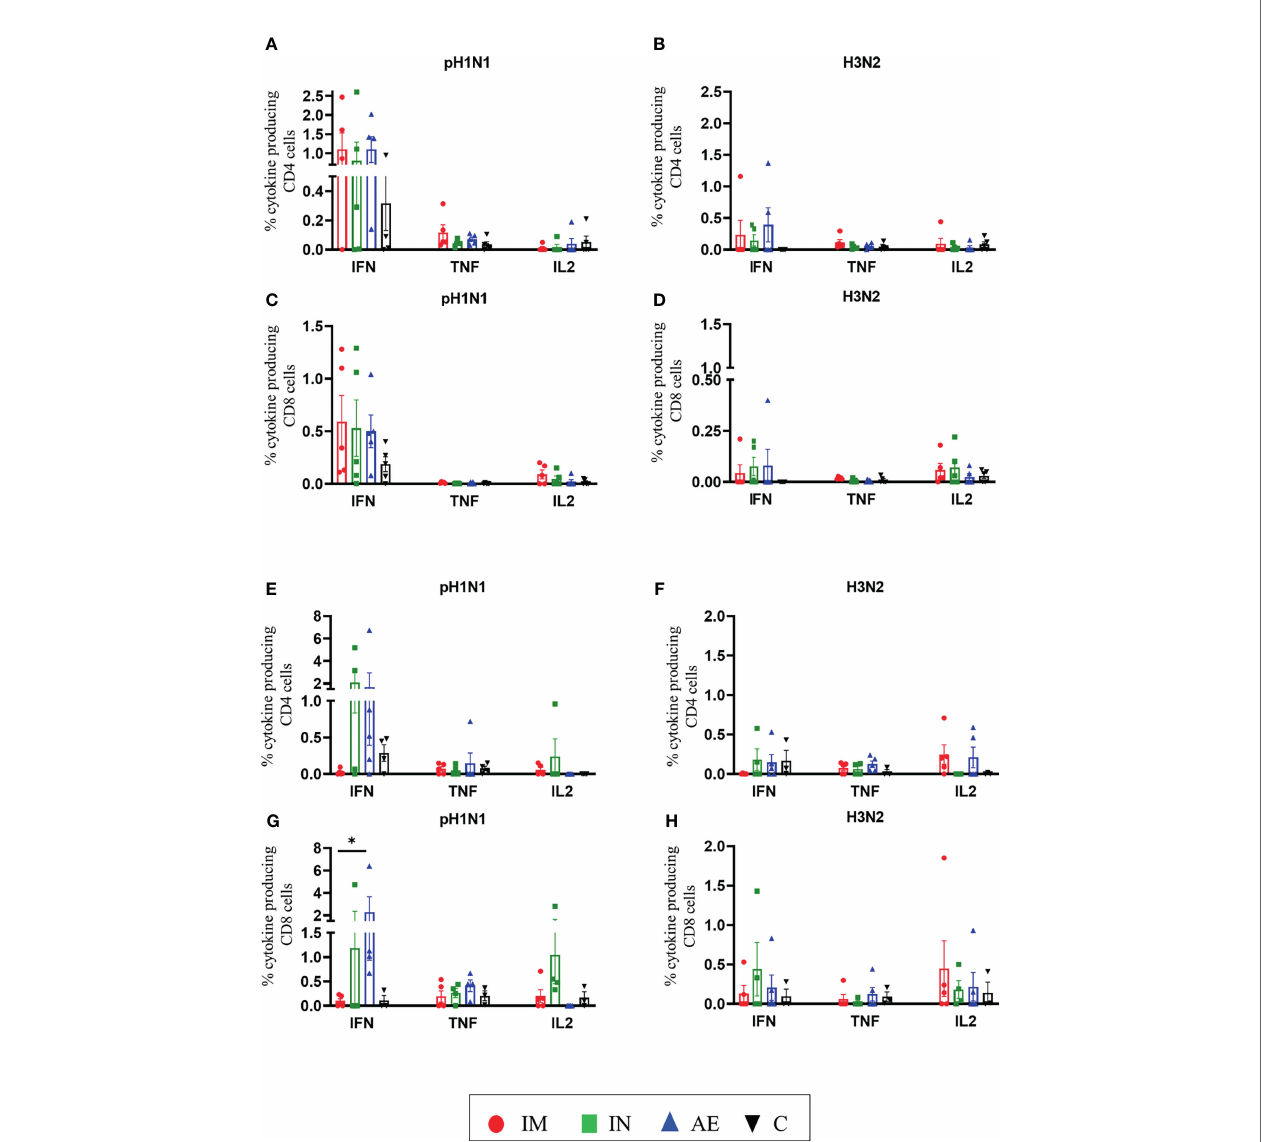
FIGURE 6 | T-cell cytokine responses in the spleen and nasal turbinates. (A – D) Spleen and (E – H) nasal turbinates were collected at 4 weeks post-immunization. Cryopreserved cells were thawed and stimulated with (A, C, E, G) pH1N1 or (B, D, F, H) H3N2, and IFN g , TNF, and IL-2 cytokine secretions were measured in CD4 and CD8 T cells by intracellular cytokine staining. Each symbol represents an individual animal; the top of the bar indicates the mean and the line the standard error mean (SEM). Two-Way ANOVA and Bonferroni multiple comparisons tests were used to compare responses between groups, and asterisks indicate signi fi cant differences (* p <